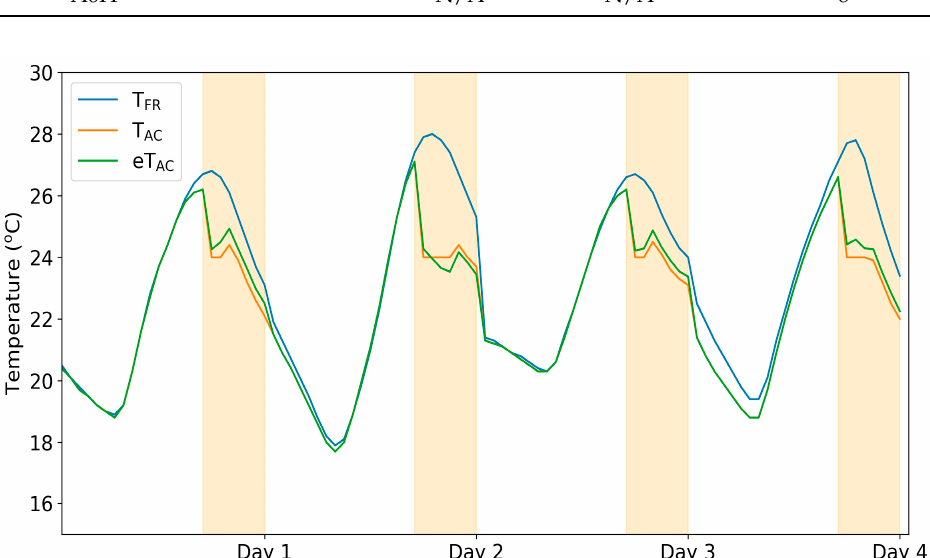
Figure 7. Time series of the free-running temperature ( T FR ), air conditioned temperature ( T AC ), and the estimated air conditioned temperature ( eT AC ) for four days for template home M2L. The light orange boxes highlight the periods of charging and